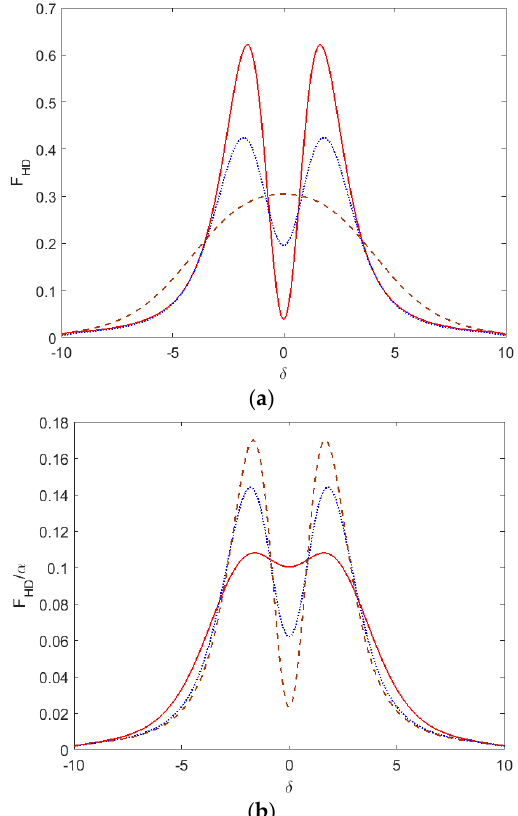
Figure 5. Holtsmark–Doppler absorption line shape F HD for different values of Doppler to Stark widths ξ : ( a ) solid line − ξ = 0.05, dotted line − ξ = 1, dashed line − ξ = 3; α = 3 and for different pulse duration parameters; α : ( b ) solid line − α = 0.5, dotted line − α = 1, dashed line − α = 2; ξ = 0.1.